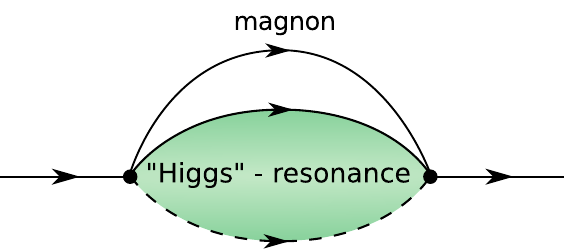
( k ) from the renormalization of the propagation of a Figure 7: Sum of all contributions to δ E 3 1 pair of α - and β -magnon which eventually form the Higgs